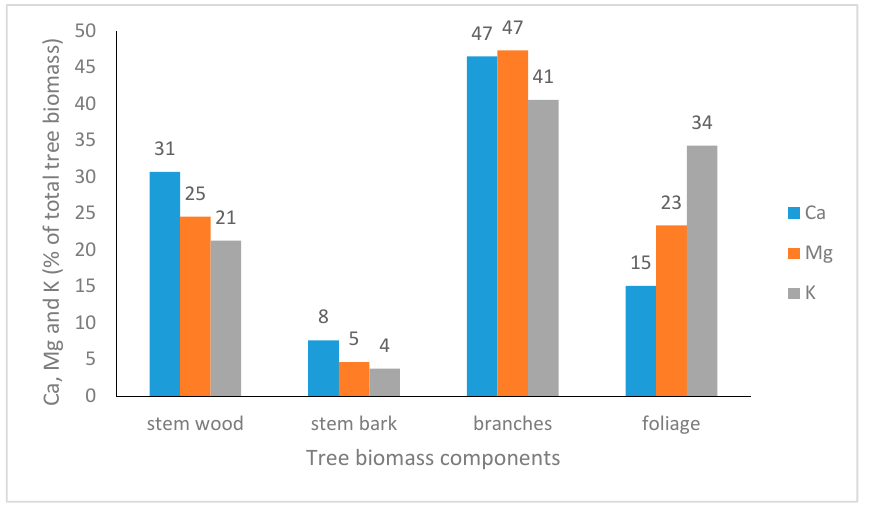
Figure 2. Base cation (Ca, Mg and K) stocks in the biomass of the different tree components for Sitka spruce. Biomass is modelled by the BSort biomass partitioning model and cation concentration measured from the ICP Forest Level II monitoring network’s three Sitka spruce